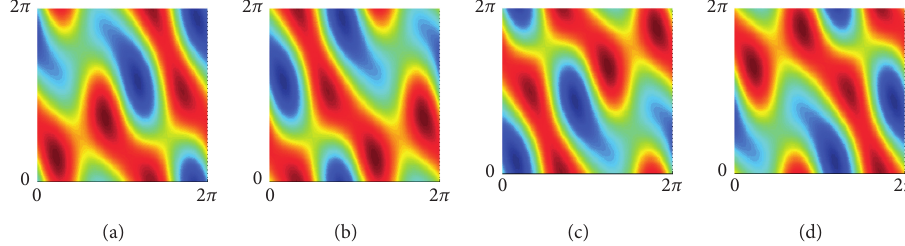
� 20 with different e � (− 1 , − 0 . 5 , 0 . 7 , − 2 . 5 , − 0 . 1 , 0